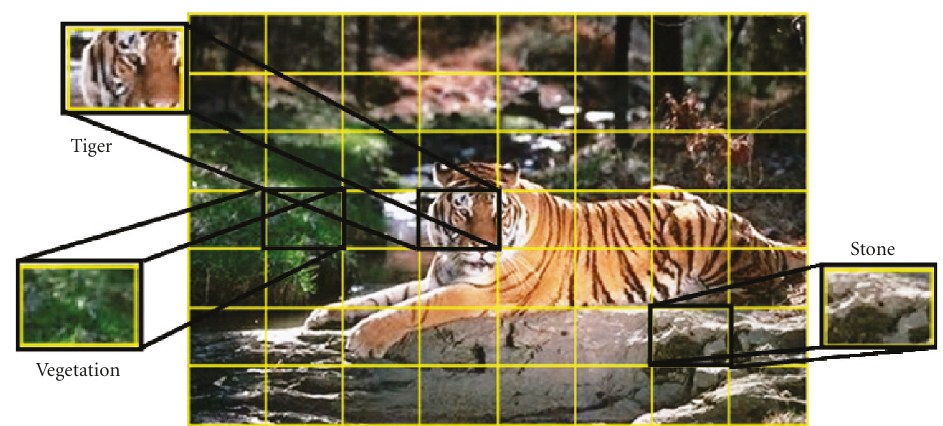
Figure 1: Elementary building blocks in an image.